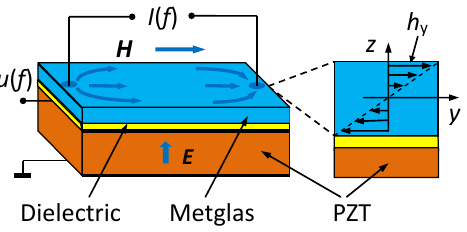
Figure 25. Schematic view of a FeBSiC/PZT heterostructure upon excitation of the ME effect by alternating current flowing through the FM layer. The arrows show directions of electric E and magnetic H fields.